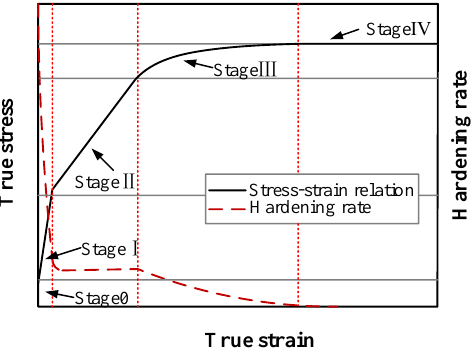
Figure 15. Stage division of typical stress–strain relationship in HEAs [38].